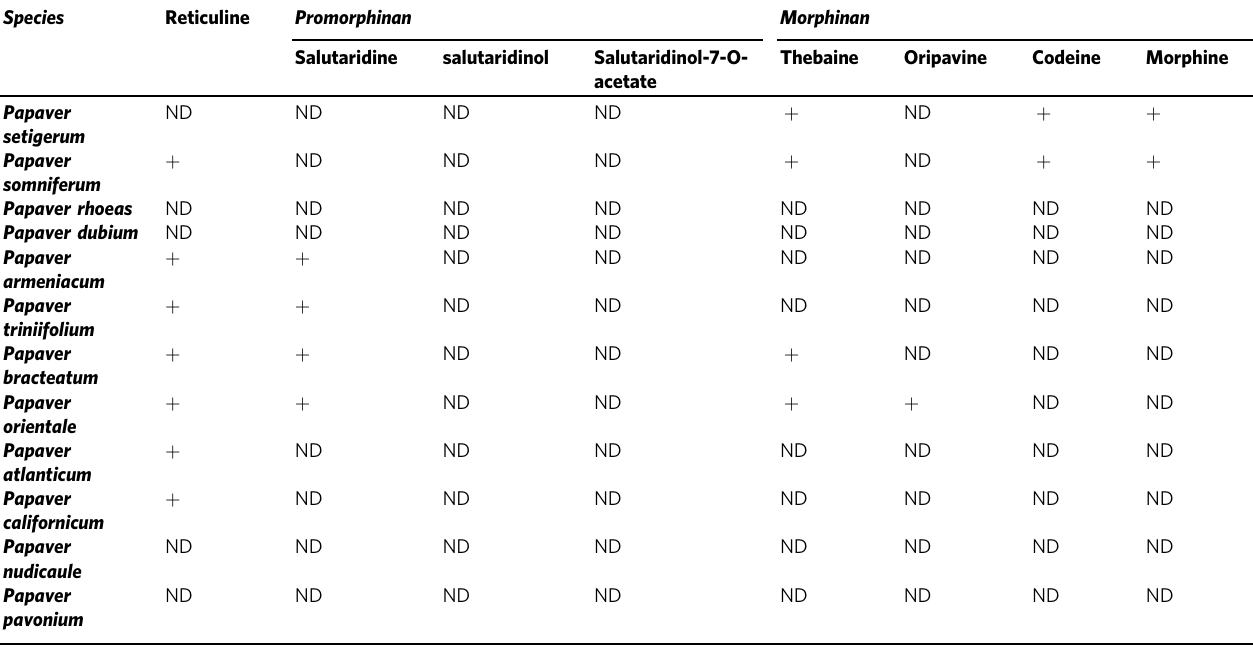
Table 1 Metabolite analysis for promorphinan and morphinan compounds in 12 Papaver